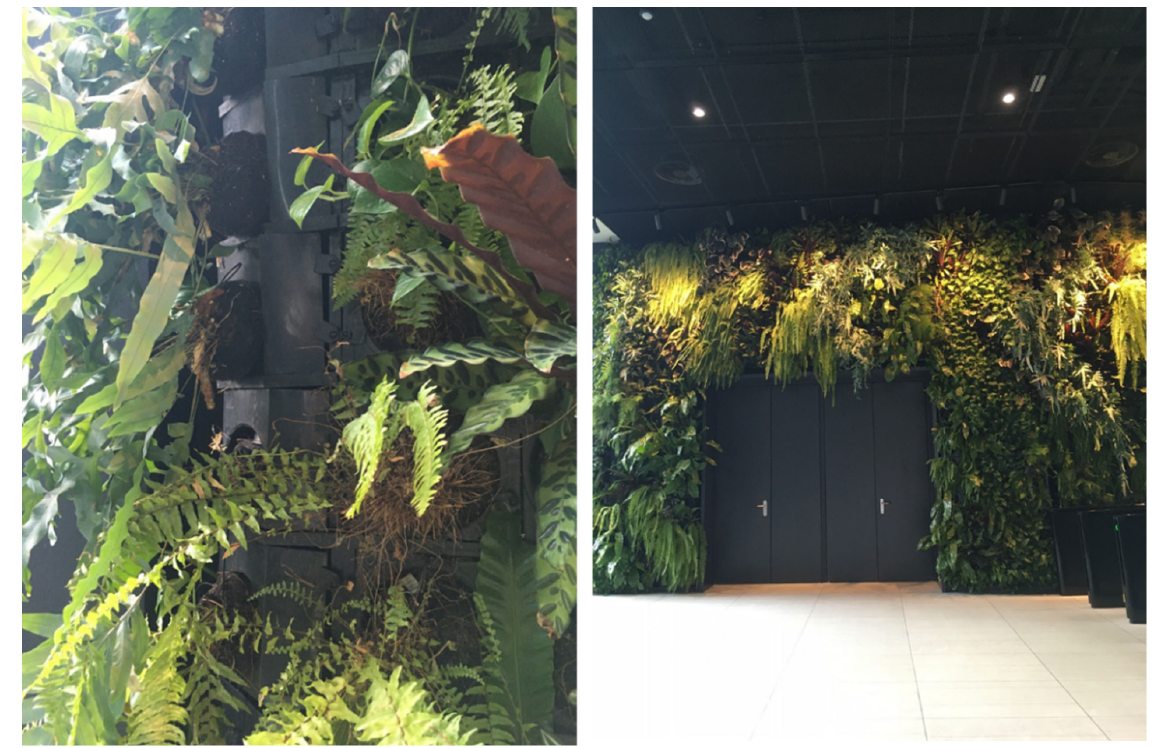
Figure 3. Modular system living wall with planter boxes in an office building (Porto Office Park, Porto ‐ Portugal). Credits: Cristina Calheiros.